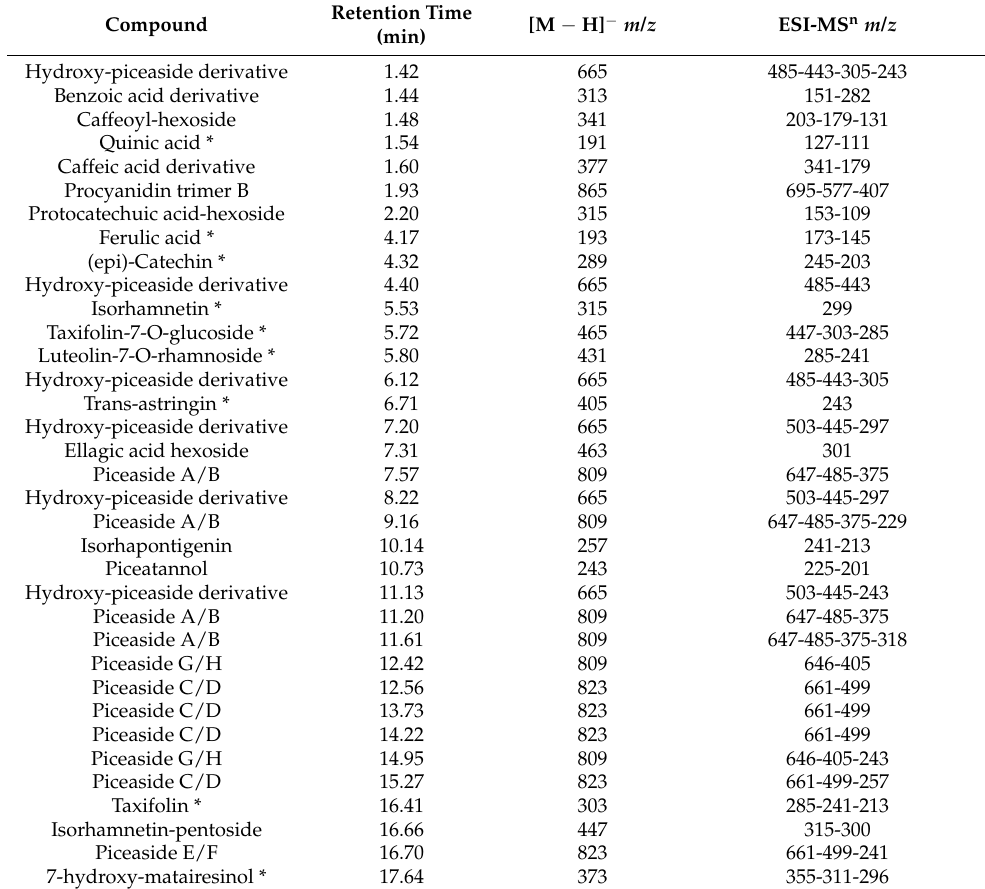
Table 3. Hydrophilic constituents of P. abies methanolic bark extract identified by HPLC-MS n . Retention Time [M − H] − Compound (min)